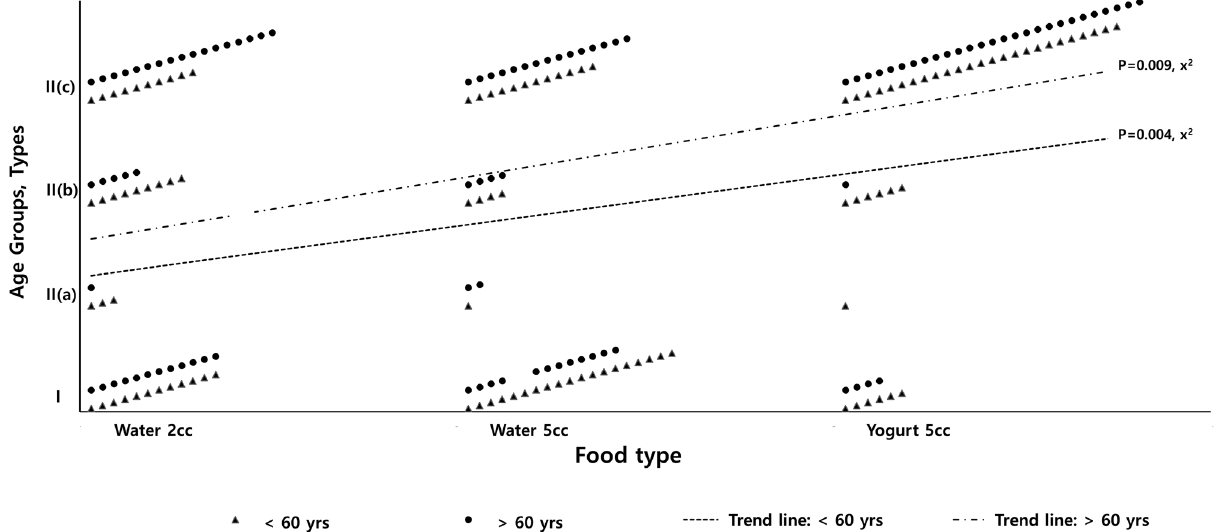
Figure 3. The distribution of S-EMG activation patterns according to the liquid characteristics in young and older groups. Trend lines in both groups show that the type II (c) pattern, which is defined as the biphasic wave, was observed in all of the SH, TH, and StH muscles and was more frequently observed when swallowing the 5 cc of yogurt in both groups.